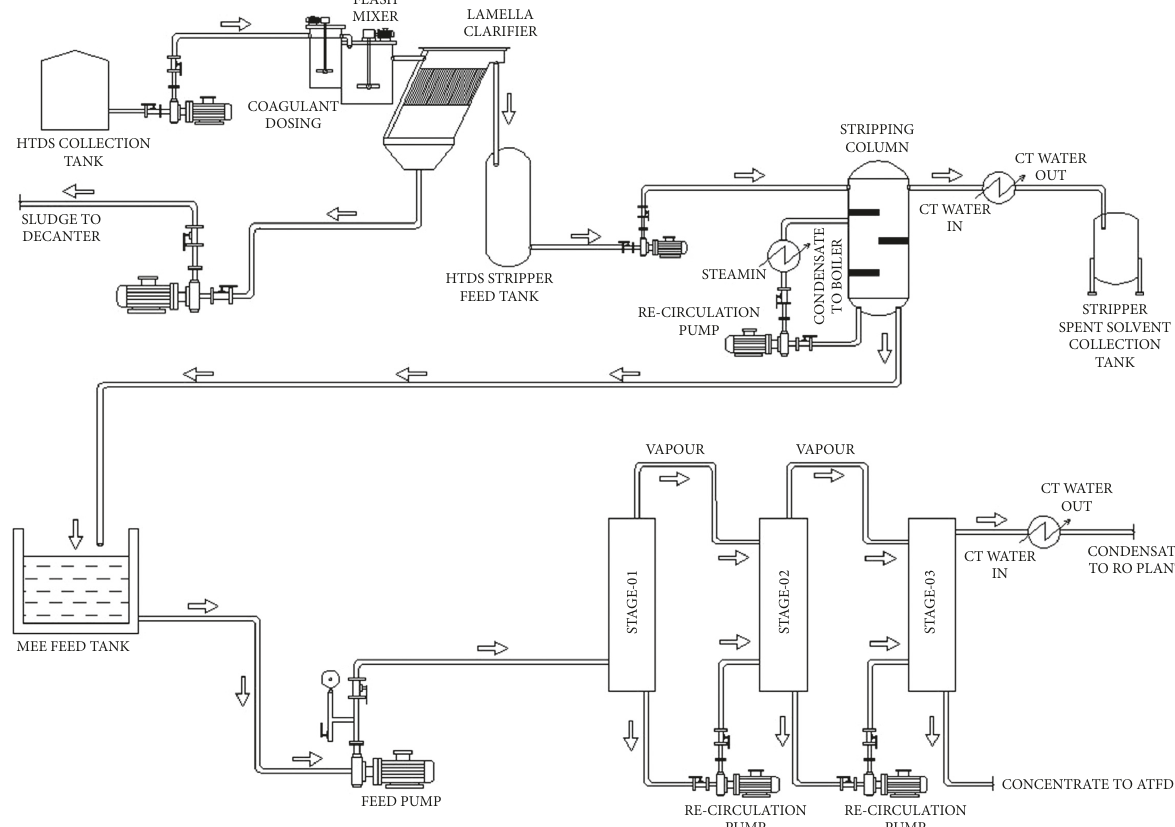
Figure 4: Block diagram of novel treatment